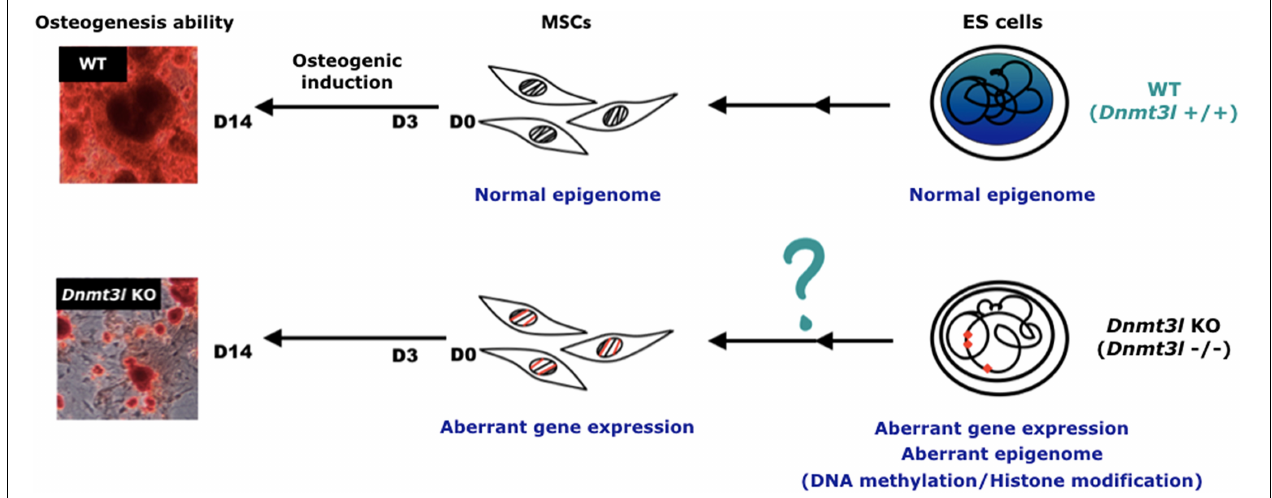
FIGURE 6 | Hypothesis of DNMT3L-mediated epigenome legacy from embryonic stem cells influencing MSC properties. We propose that the expression of DNMT3L in ES cells is essential to maintain the normal epigenome. Some of these DNMT3L associated epigenomic landscape may be carried over all the way from pluripotent stem cells to influence isolated MSC properties from adult mice, and their self-renewal and differentiation abilities in